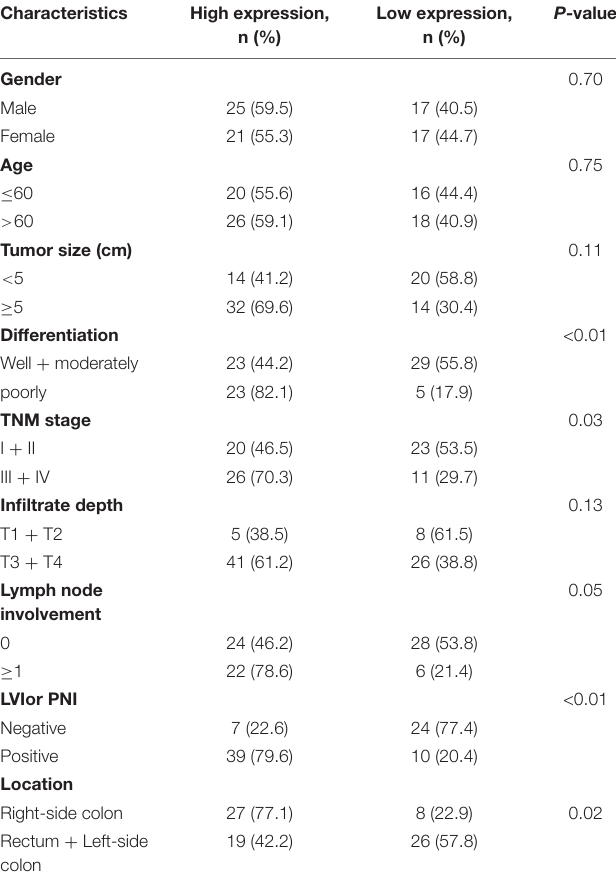
TABLE 2 | The detail information of COAD